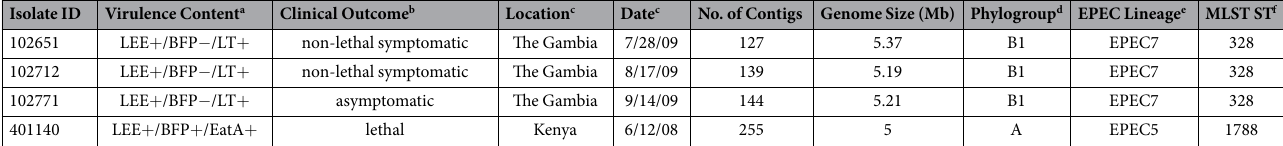
Table 1. Characteristics of the EPEC/ETEC hybrid isolates. a The virulence content is the pathovar-specific putative protein-encoding virulence genes identified in each of the hybrid isolates. b The clinical outcome of the patient that each isolate was cultured from. c The location and date of isolation of the patient samples the hybrid isolate was cultured from. d The E. coli phylogroups are the same as those previously described (Jaureguy et al . 35 , Tenaillon et al . 36 ). e The EPEC phylogenomic lineages correspond with those previously described (Hazen et al . 16 ). f The multilocus sequence types were determined using the database hosted by the University of Warwick